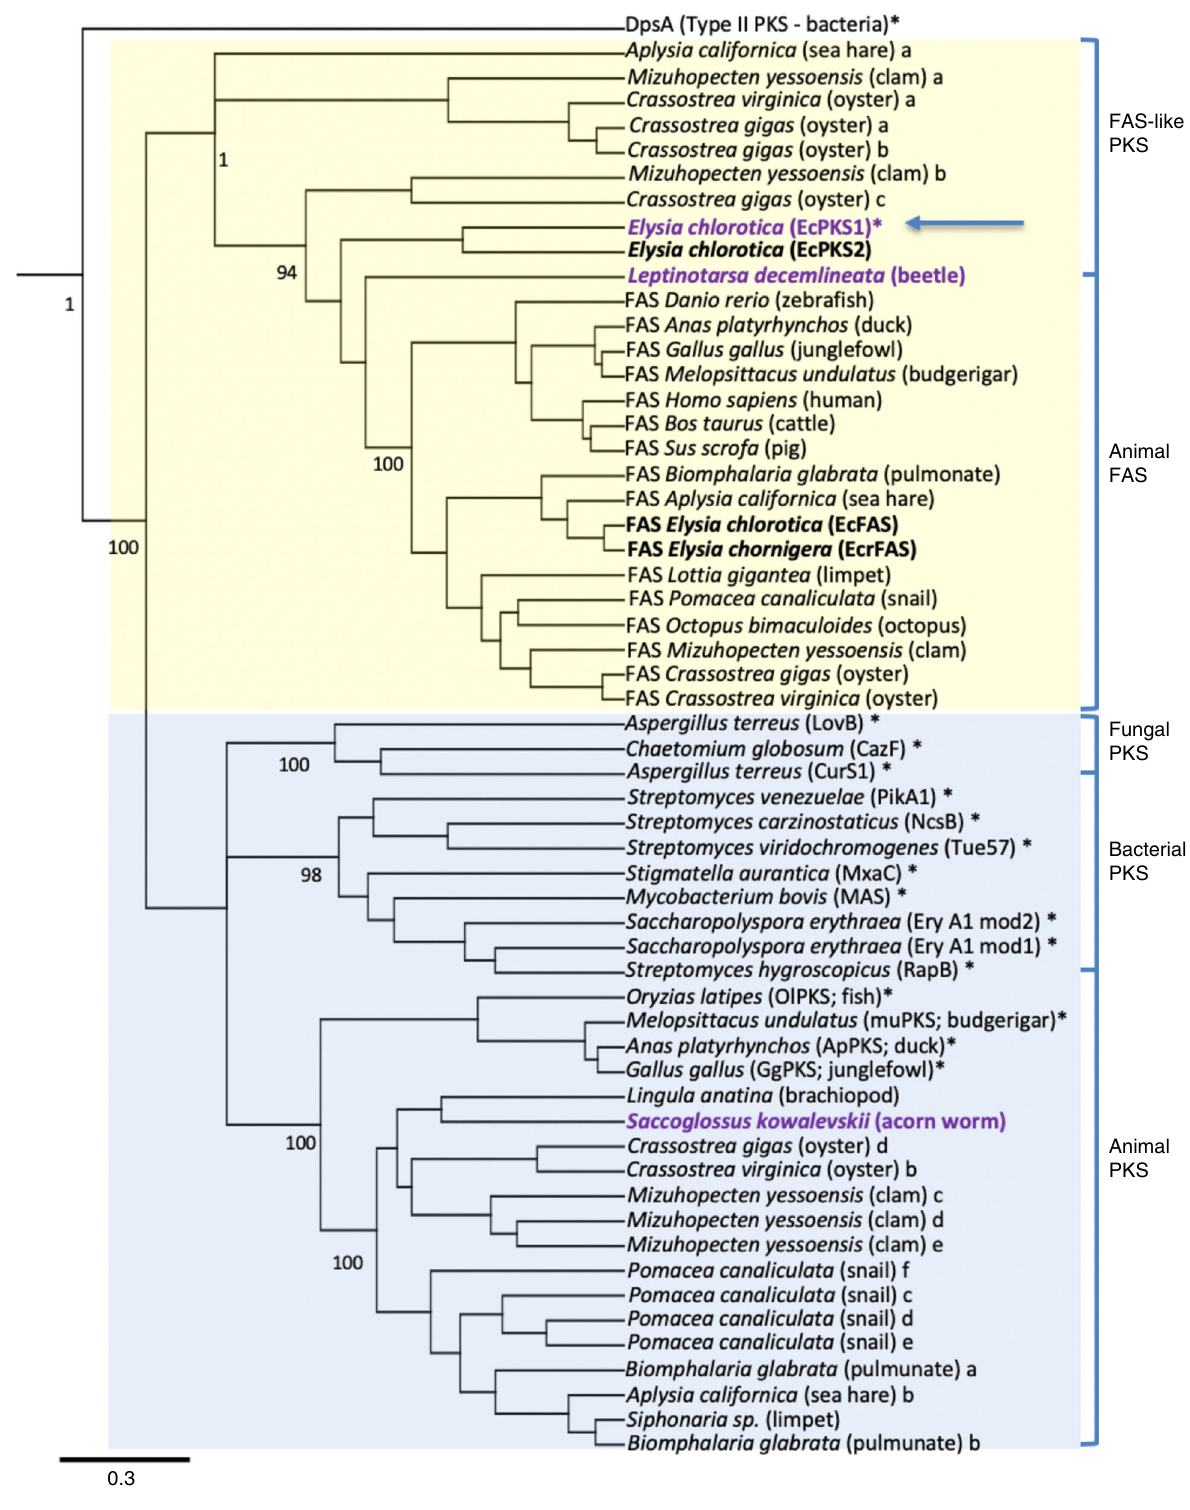
Fig. 6 EcPKS1 represents a widespread group of FAS-like PKSs in animals. A phylogenetic tree inferred using Bayesian method was created using protein sequences of ketosynthase domains representing a broad range of characterized and uncharacterized Type I PKSs and FASs. DpsA, a ketosynthase from a Type II PKS, was used as an outgroup. Numbers indicate posterior probability in percent; only key nodes are shown. Asterisk indicates that the protein and / or gene have been characterized. (Animal FAS is also well characterized.) Purple names are for putatively methylmalonate-selective PKSs. In bold are shown sequences discussed in the main text. Letters indicate multiple proteins encoded in the same sequenced genome. The FAS-like PKS group is described in this